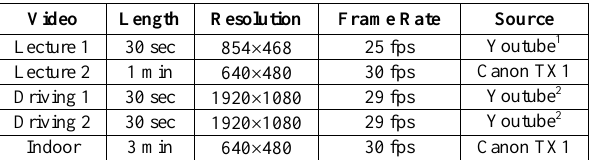
TABLE I. D ETAILS OF THE VIDEOS USED IN THE EXPERIMENTS